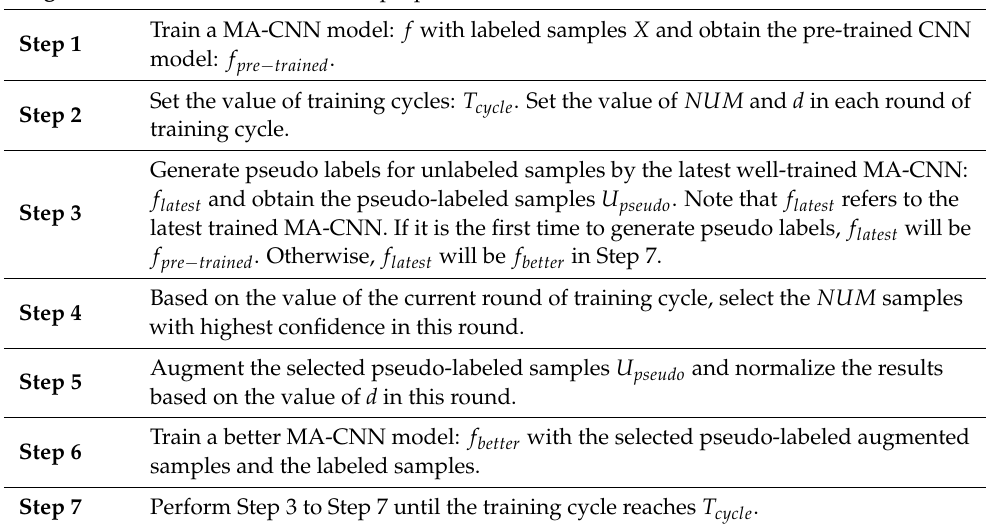
Algorithm 4. The framework of our proposed